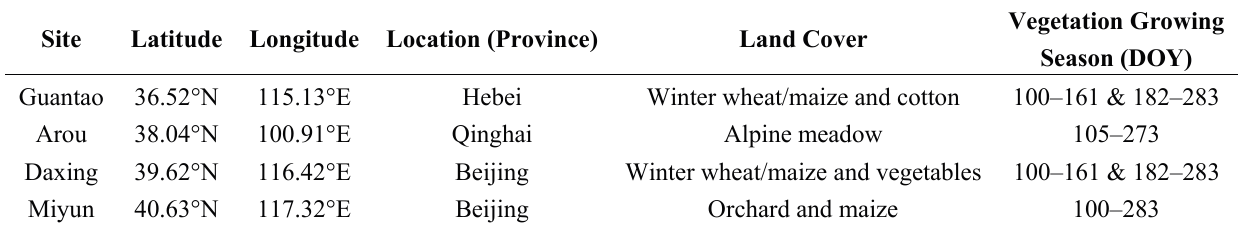
Table 2. Summary of the surface characteristics of the four sites.